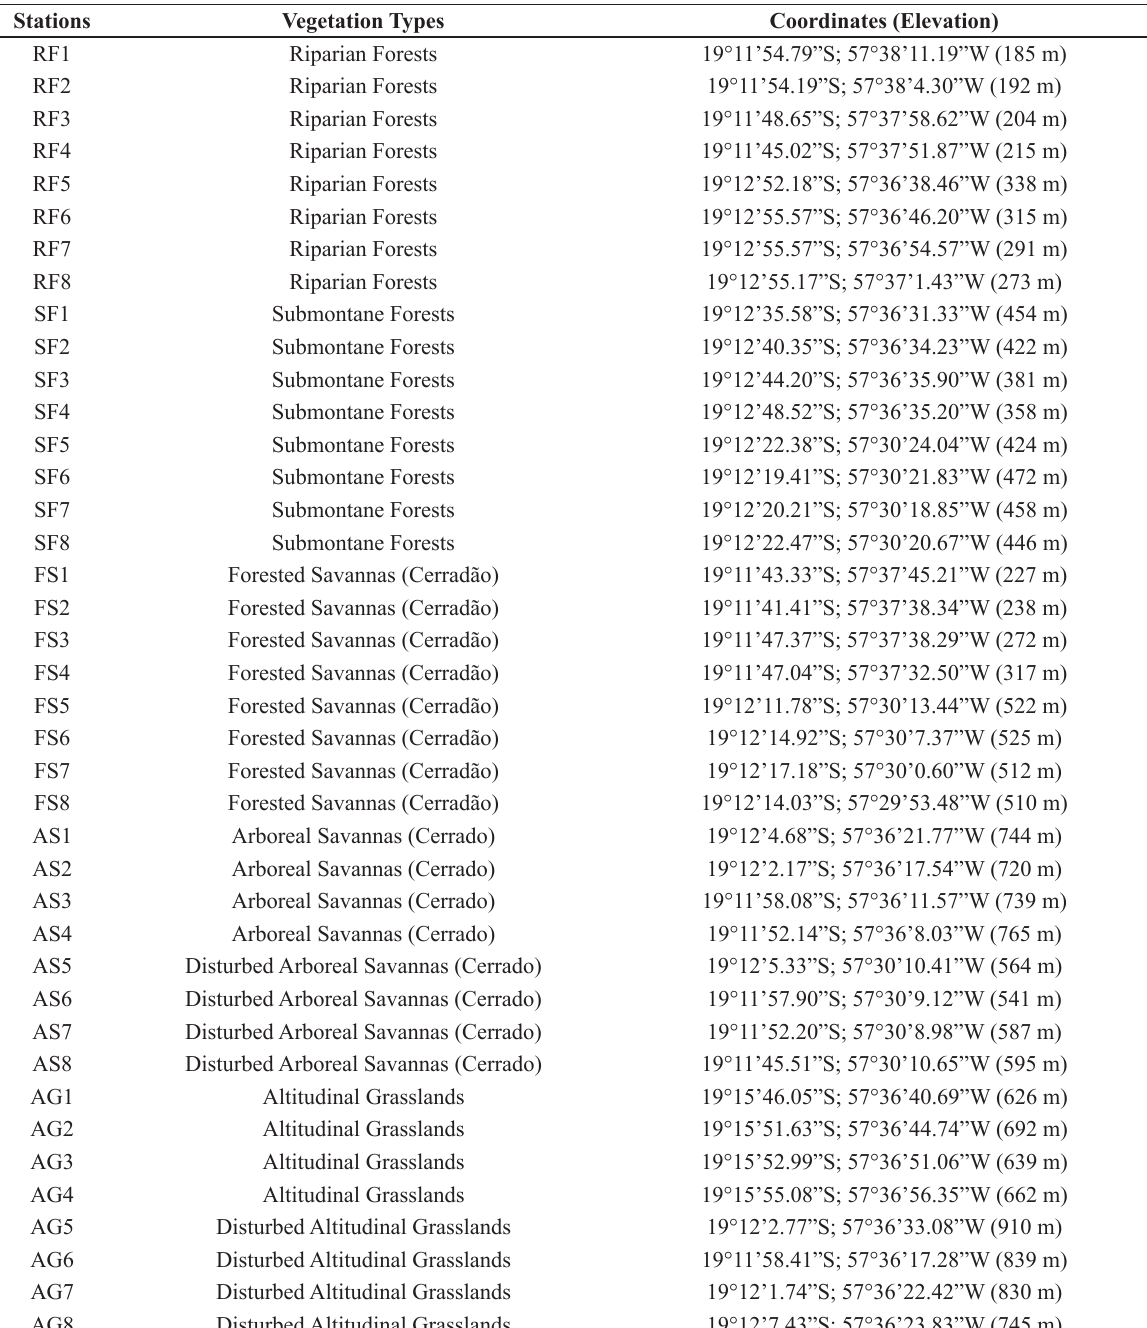
Stations used for sampling bird communities along the vegetation gradient in Maciço do Urucum, western